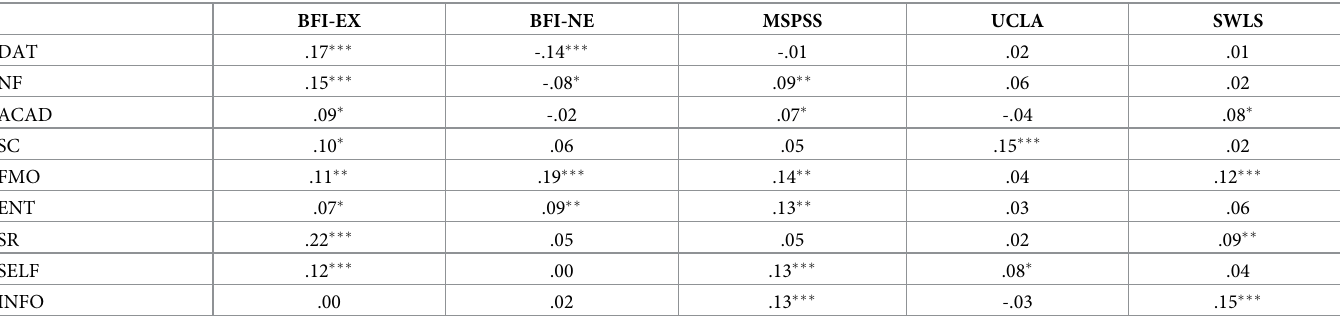
Table 8. Correlations between SMU-SNS factors and other relevant